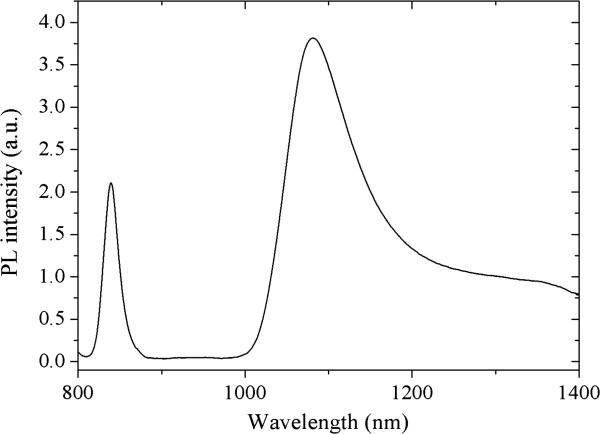
PL emission from the investigated sample at T = 100 K.